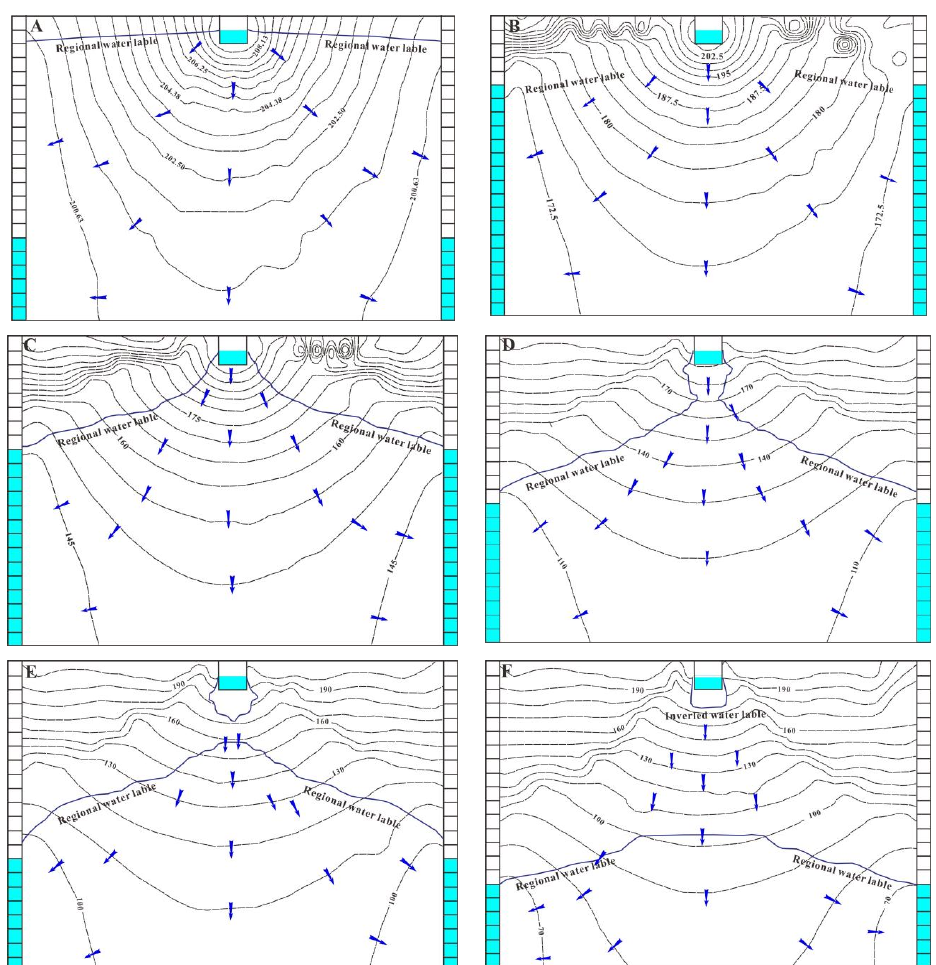
Figure 10. The change in the relationship between river water and groundwater in the sandbox experiment under the water-bearing medium sand A and a river water depth of 10 cm. Discharge water level ( A ): 200 cm, ( B ): 170 cm, ( C ): 140 cm, ( D ): 100 cm, ( E ): 90 cm, and ( F ): 60 cm.